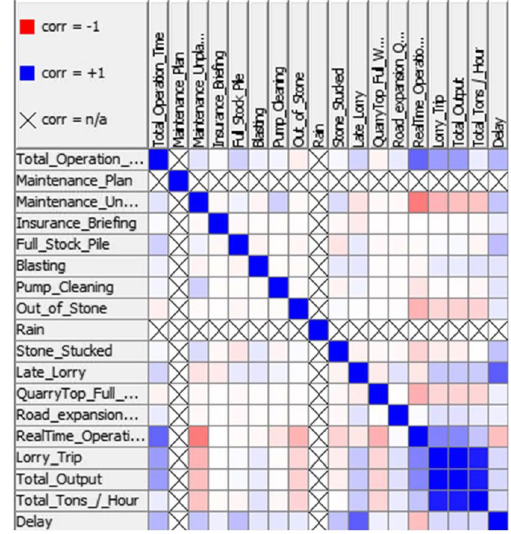
Fig. 5 Correlation coefficients of